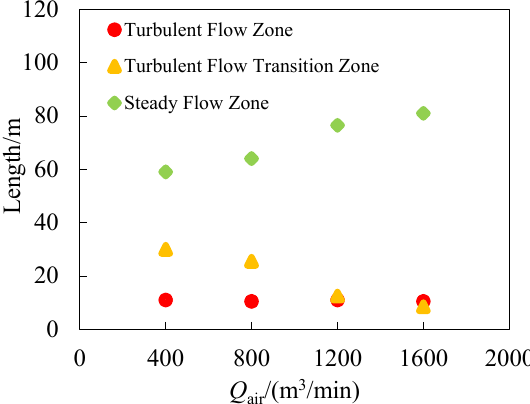
Figure 6. The lengths of the three zones under different forced air volumes.